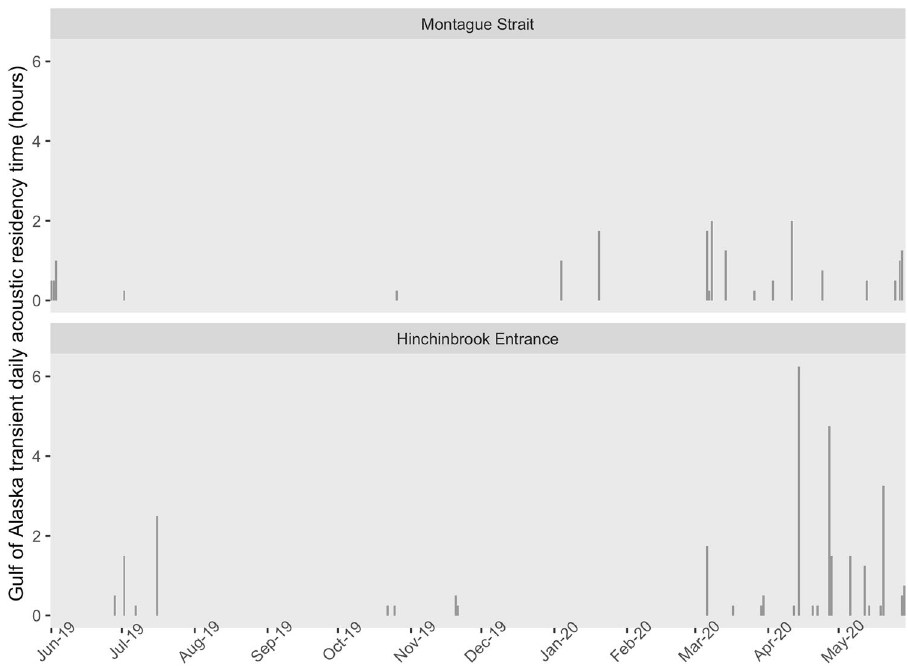
Figure 4. Hours per day with Gulf of Alaska transient killer whale detections in Montague Strait and Hinchinbrook Entrance, Gulf of Alaska, June 2019 to May 2020.